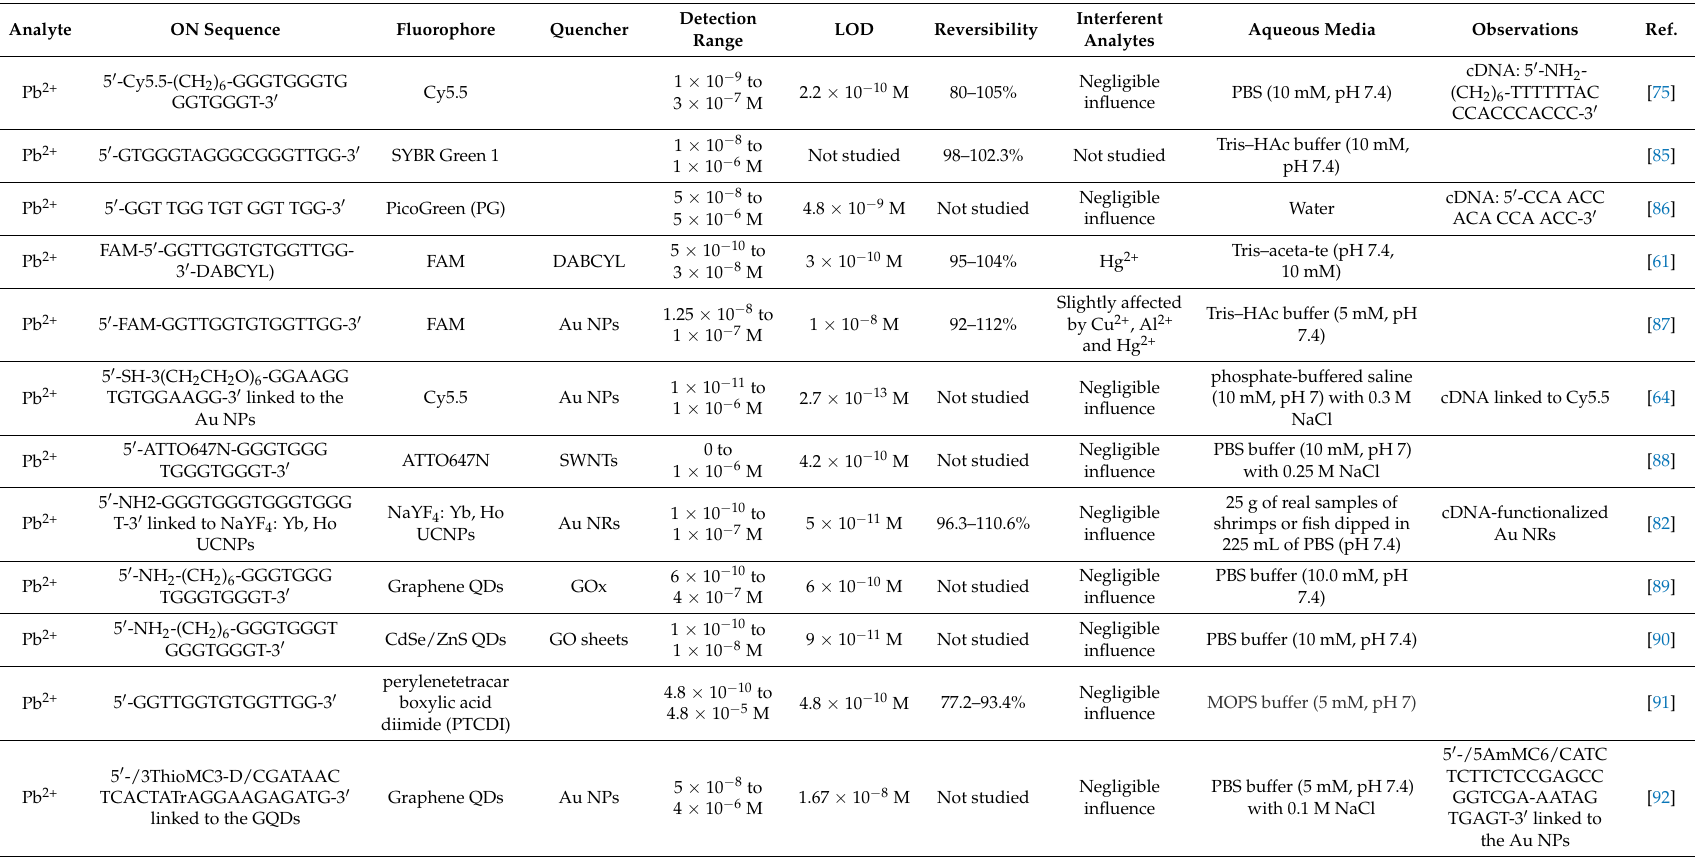
Table 2. Pb 2+ fluorescent sensors based on aptamer